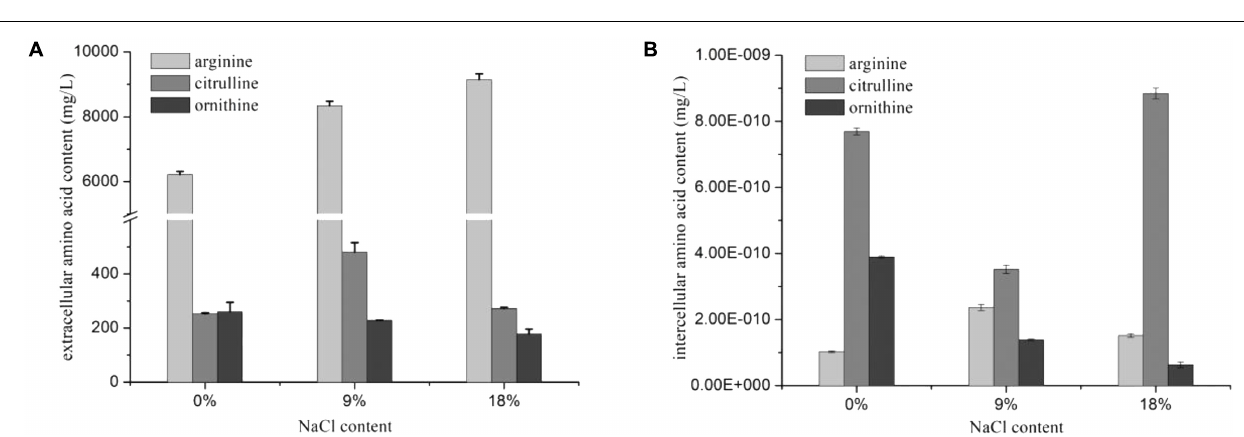
FIGURE 3 | Extracellular (A) and intercellular (B) amino acids of W. confusa in the presence of different NaCl